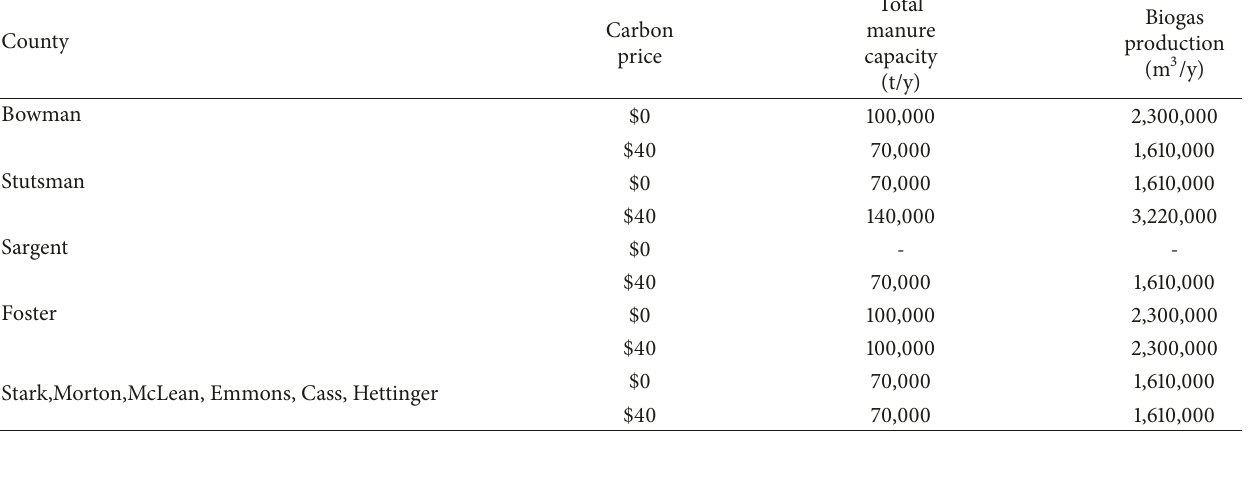
Table 5: Total manure processing and biogas production in each county at carbon price of $0 and carbon price of $40.